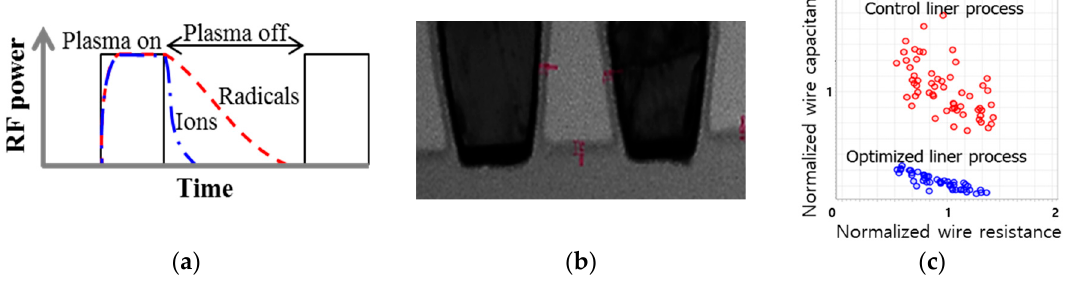
Figure 8. AG liner optimization. ( a ) Process of pulsed-plasma chemical vapor deposition (CVD). ( b ) TEM image showing the sidewall and bottom coverage of the optimized liner process. ( c ) R–C plots for different liner processes.